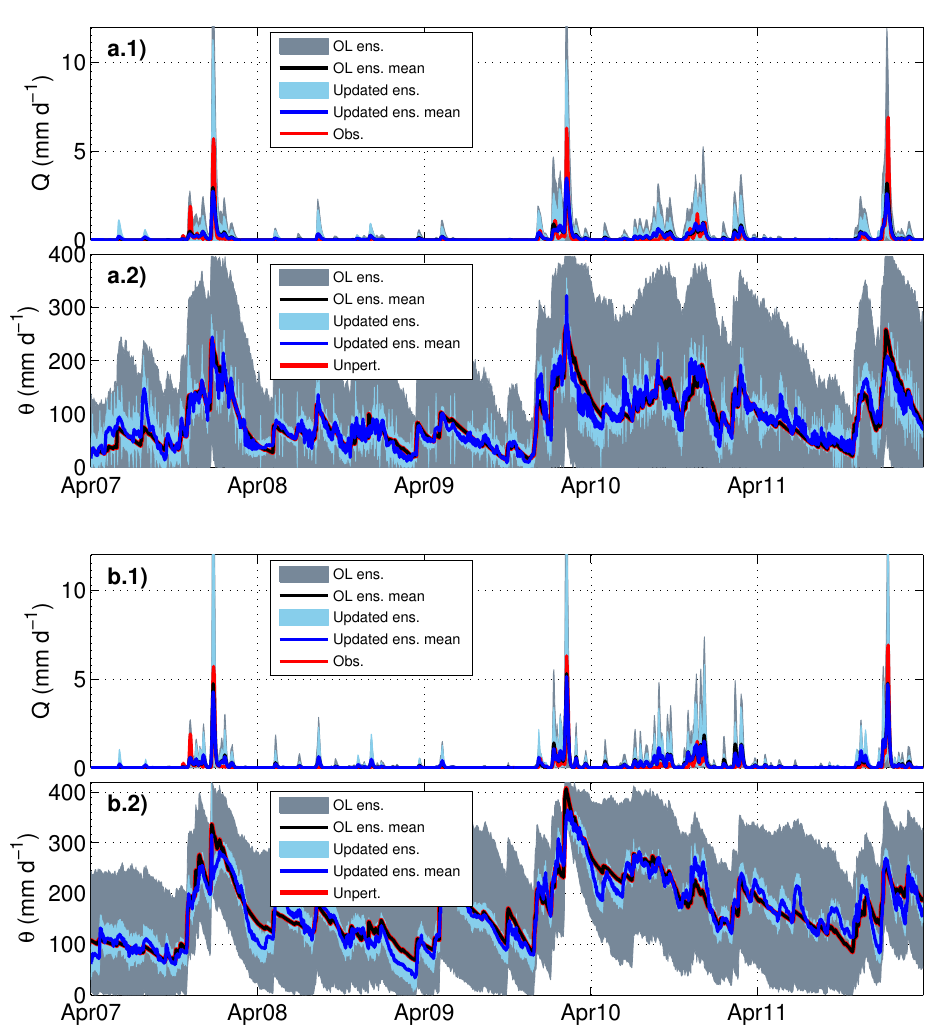
Figure 10. Streamflow ( Q in mmd − 1 ) and soil moisture ( θ in mmd − 1 ) ensemble prediction at the catchment outlet, before and after SM-DA for evaluation sub-period 2 (1 May 2007–2 March 2014), which had three major flooding events. (a.1) and (a.2) present the results for the lumped model. (b.1) and (b.2) present the results for the semi-distributed model.